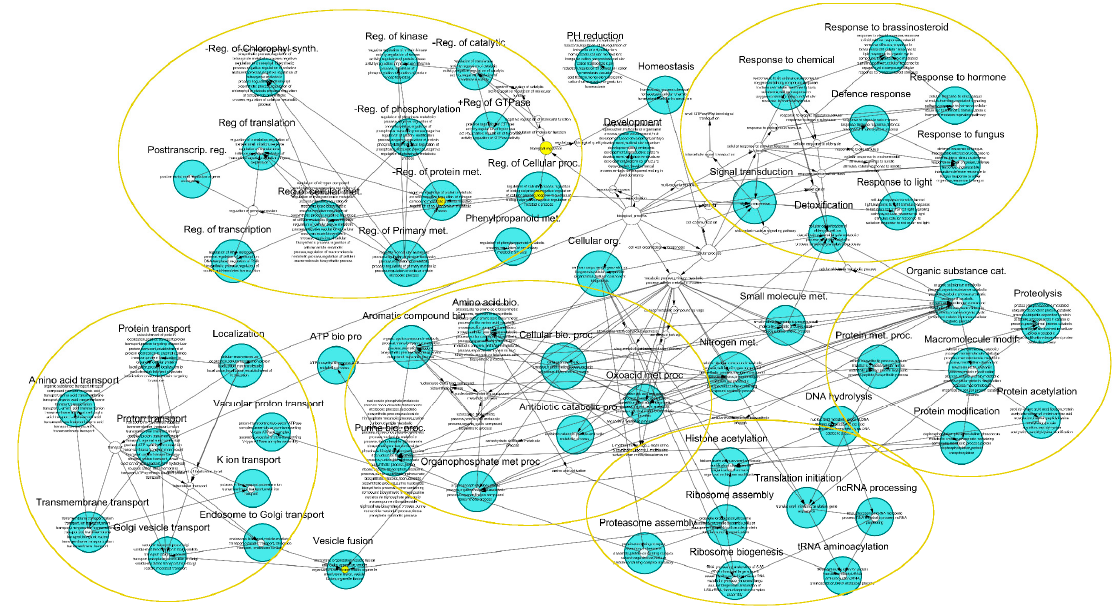
Figure 4. Gene network formed by Irbe DNA TE presence in the gene introns of P. taeda v.2.0.